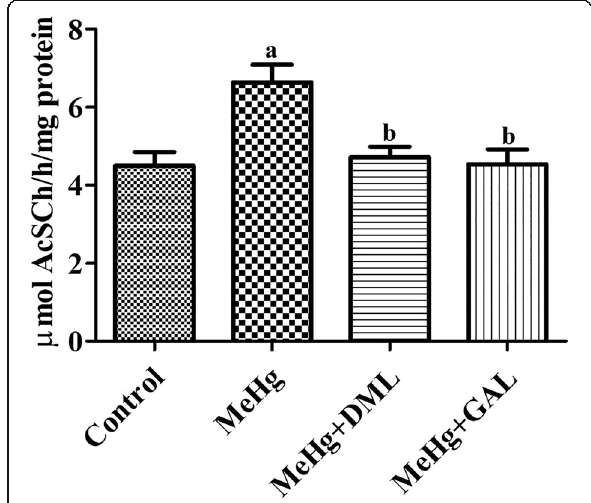
Fig. 5 Acetylcholinesterase (AChE) activity in hippocampal synaptosomes of the control group, dimethylmercury (MeHg)- treated group, Dendropanax morbifera leaf extract treated group with MeHg (MeHg+DML) and and galantamine (GAL) treated group with MeHg (MeHg+GAL). Hippocampal AChE activity is expressed